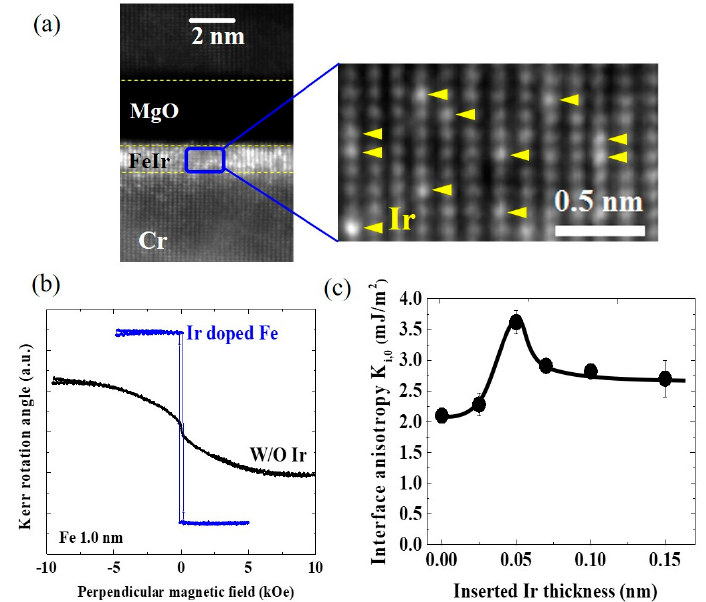
Figure 13. ( a ) HAADF-STEM images of a multilayer structure of Cr/ultrathin Ir-doped Fe/MgO. Inter- diffused Ir atoms can be identified by atomic-scale Z-contrast HAADF-STEM imaging as indicated by the yellow arrows. ( b ) Comparison of the polar MOKE hysteresis curves for pure Fe (1 nm)/MgO and Fe (1 nm)/Ir (0.1 nm)/MgO structures. ( c ) Dependence of the intrinsic interface magnetic anisotropy energy, K i,0 , on the thickness of the Ir layer. Reproduced from [35]. CC BY 4.0.